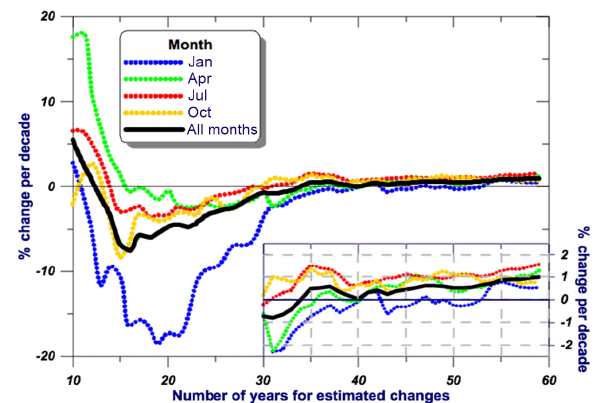
Figure 6. Percent change per decade for different timescales and different months using 1954 as the starting year (the last 30-year period is magnified with changes presented as percent per